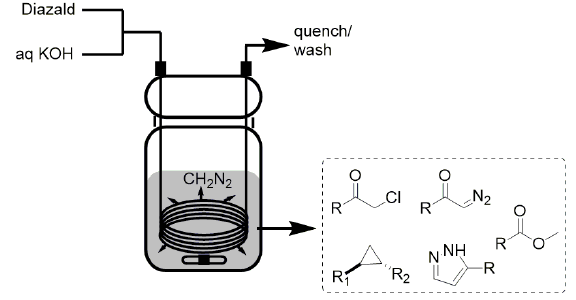
Figure 16 - In situ generation of anhydrous solutions of diazomethane in a semibatch